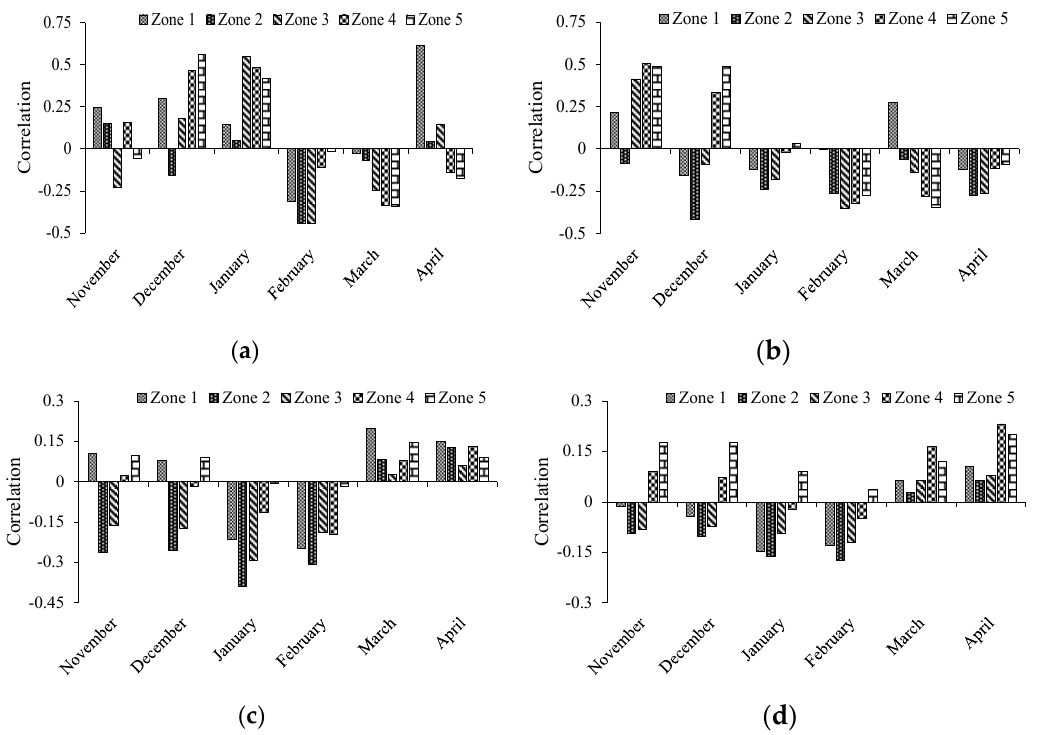
Figure 8. The correlation between the detrended Standardized Precipitation Index (SPIs) and Stand- ardized Yield Residual Series ( SYRS ) for the wheat crop.( a ) SP-1; ( b ) SP-3; ( c ) SP-6; ( d ) SP-12.